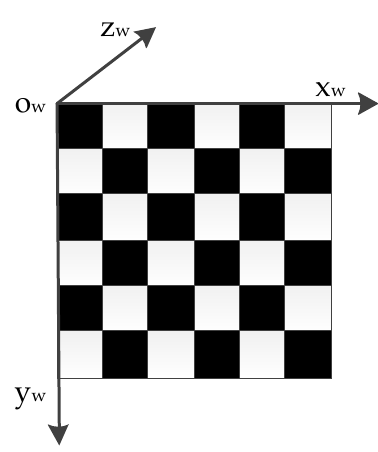
Figure 4. World coordinate system when performing camera calibration.